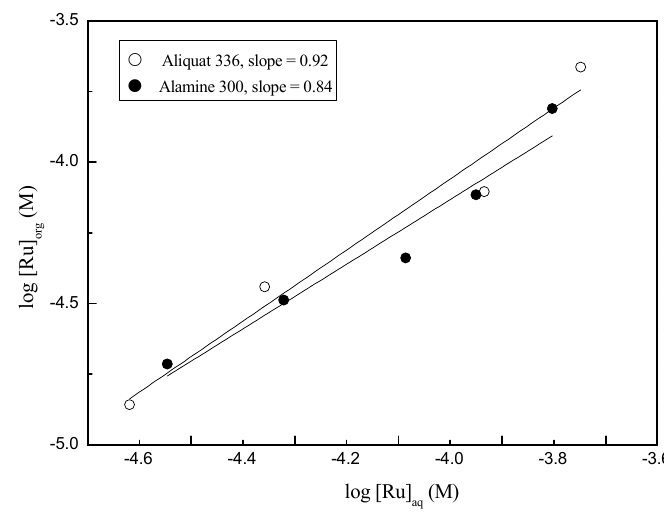
Figure 4. Identification of the extracted species of Ru(III) into Alamine 300 and Aliquat 336 from 3 M HCl solution. ([Extractant] = 0.01 M and [Ru(III)] = 10–100 mg / L). 3.2.2. Stripping of Ru(III) from the Loaded Aliquat 336